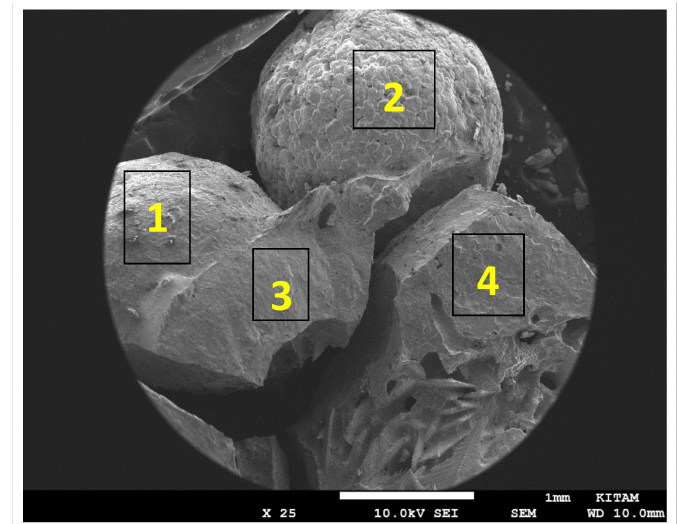
Figure 8. SEM of BaTiO 3 particles obtained after microwave irradiation at 1800 W for 10 min with plasma generation in air showing microwave plasma induced sintering, particle surface and fracture surface characteristics, void formation and electrical treeing.